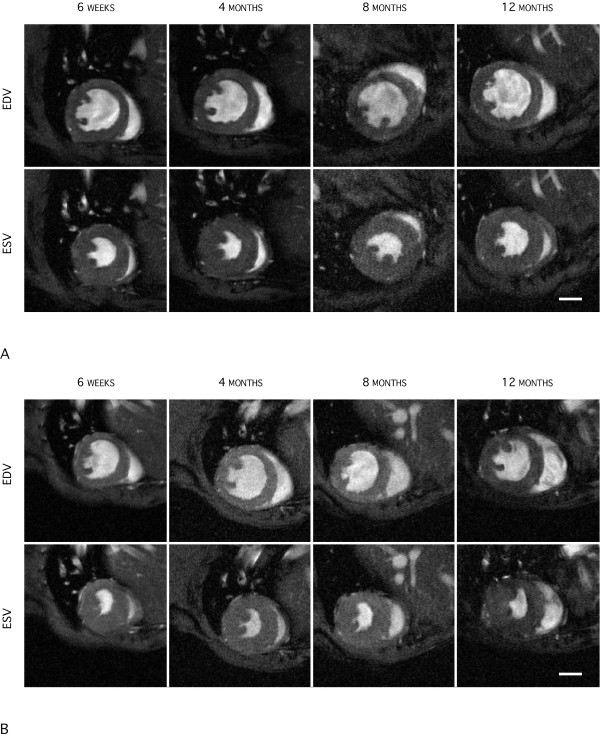
(a) Mid-ventricular end-diastolic (top row) and end-systolic (bottom row) frames in the short-axis orientation of a male wild type mouse heart for the four different time points covering the study duration of one year. (b) Corresponding mid-ventricular end-diastolic (top row) and end-systolic (bottom row) frames in the short-axis orientation of a male GAMT-ko mouse heart at the respective time points. While the hearts of the transgenic mice were significantly smaller, cardiac function did not deteriorate over time, despite the lack of creatine. Scale bars: 2 mm.